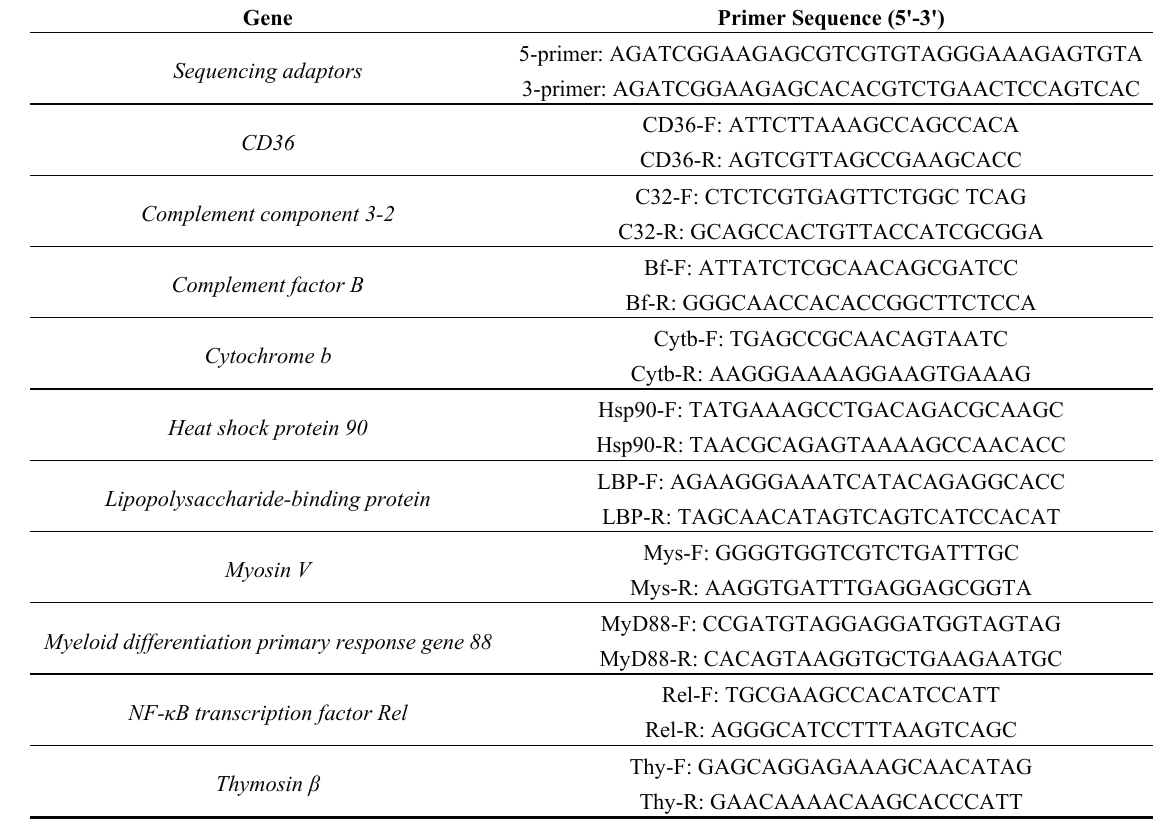
Table 2. Primers used for libraries construction and